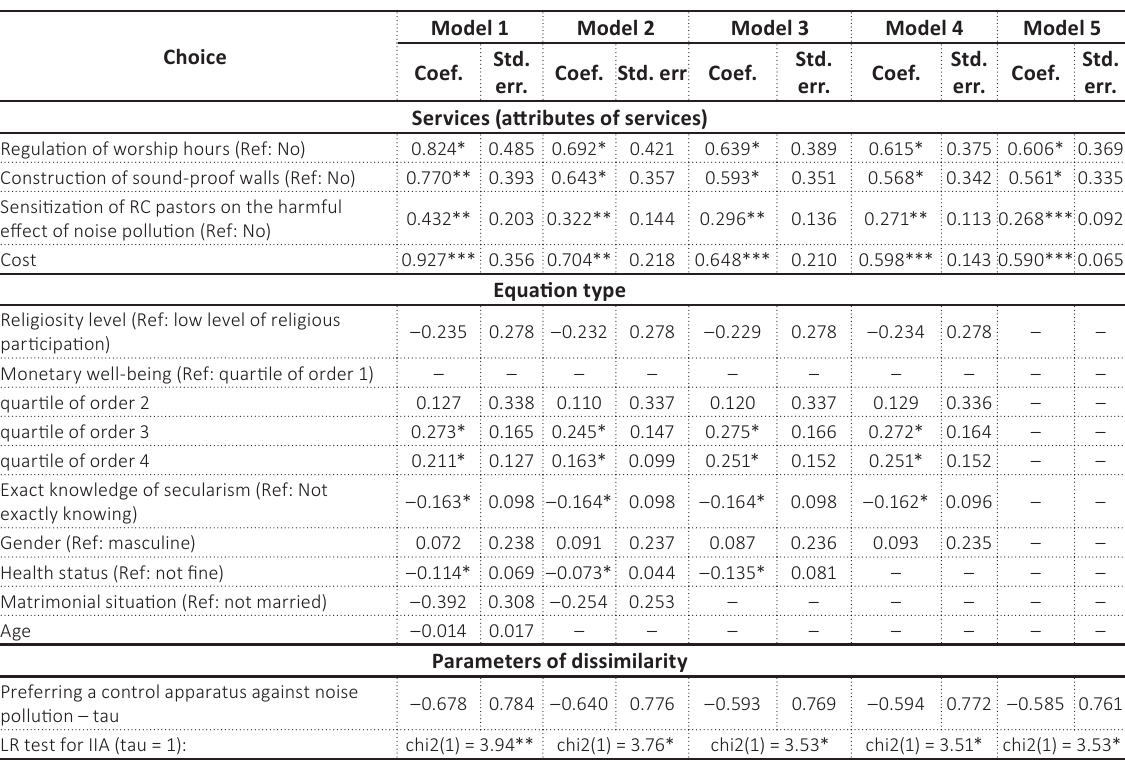
Table 5. Results of the estimation of the nested logit